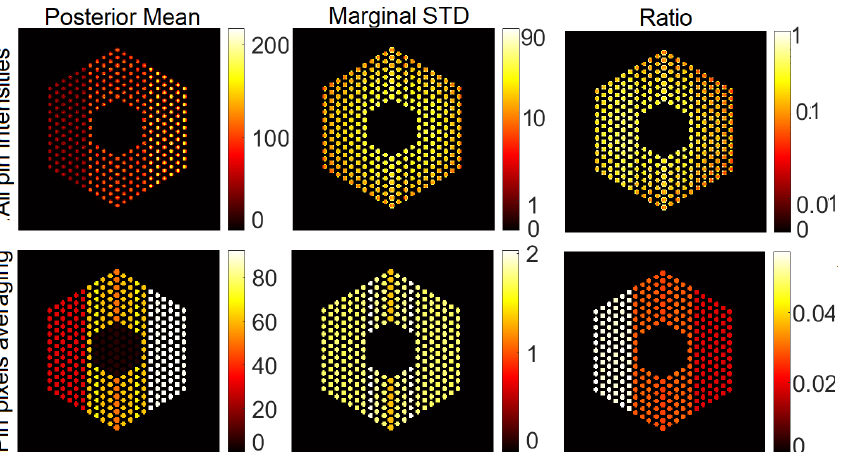
Figure 4. Results of the proposed approach using the Gaussian noise model, when the peak value is set to 220 and noise variance is set to σ 2 = 2 × 10 − 3 . Column 1: posterior mean, Column 2: marginal standard deviation and Column 3: ratio of marginal standard deviation divided by posterior mean. Row 1: All pixels, and Row 2: pin pixels